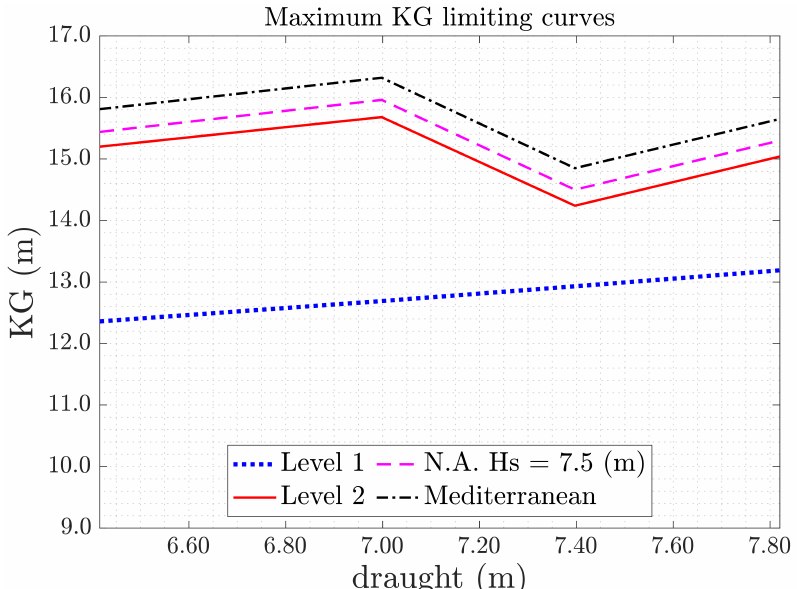
Figure 6. Vulnerability assessment in terms of maximum KG limiting curve for the pure loss of stability failure mode. Curves obtained according to the results for the application of Level 1, Level 2, Level 2 for North Atlantic Ocean limited to H S = 7.5 ( m ) and Level 2 for